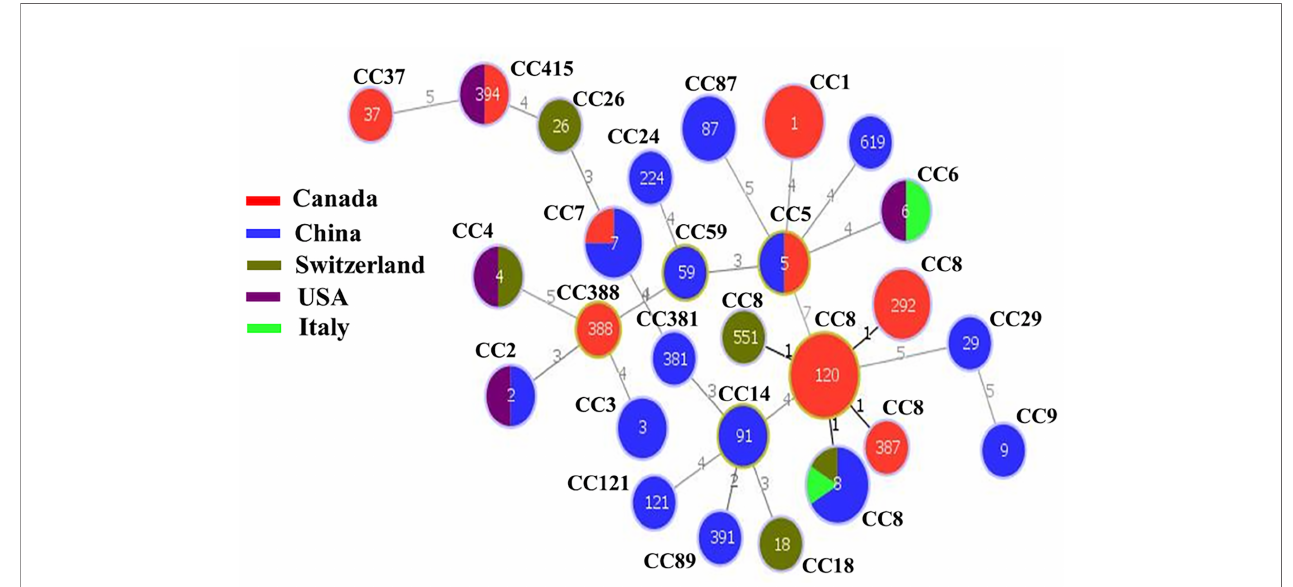
FIGURE 3 | The minimum spanning tree (MST) illustrating the phylogenetic relationship based on sequence types (STs) allelic pro fi les of clinical strains of worldwide Listeria monocytogenes isolates. There are 60 isolates from various countries including China, Canada, Switzerland, USA, and Italy. Each circle represents one ST. The size of the circle is proportional to the number of isolates, and the color within the circle represents country of isolates. Links between the circles are represented according to the number of allelic mismatch between STs.